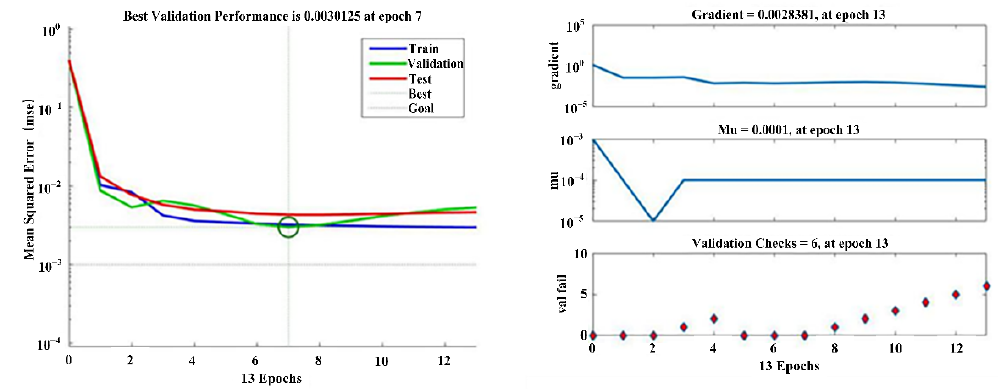
Figure 5. Training error curve of the DWQM model.